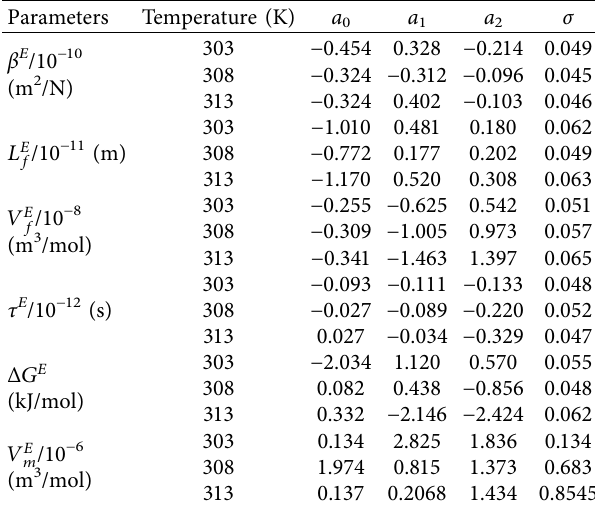
Table 4: Redlich–Kister coefficients and standard deviations of chlorpheniramine and 1-propanol at 303K, 308K, and 313K in the atmospheric